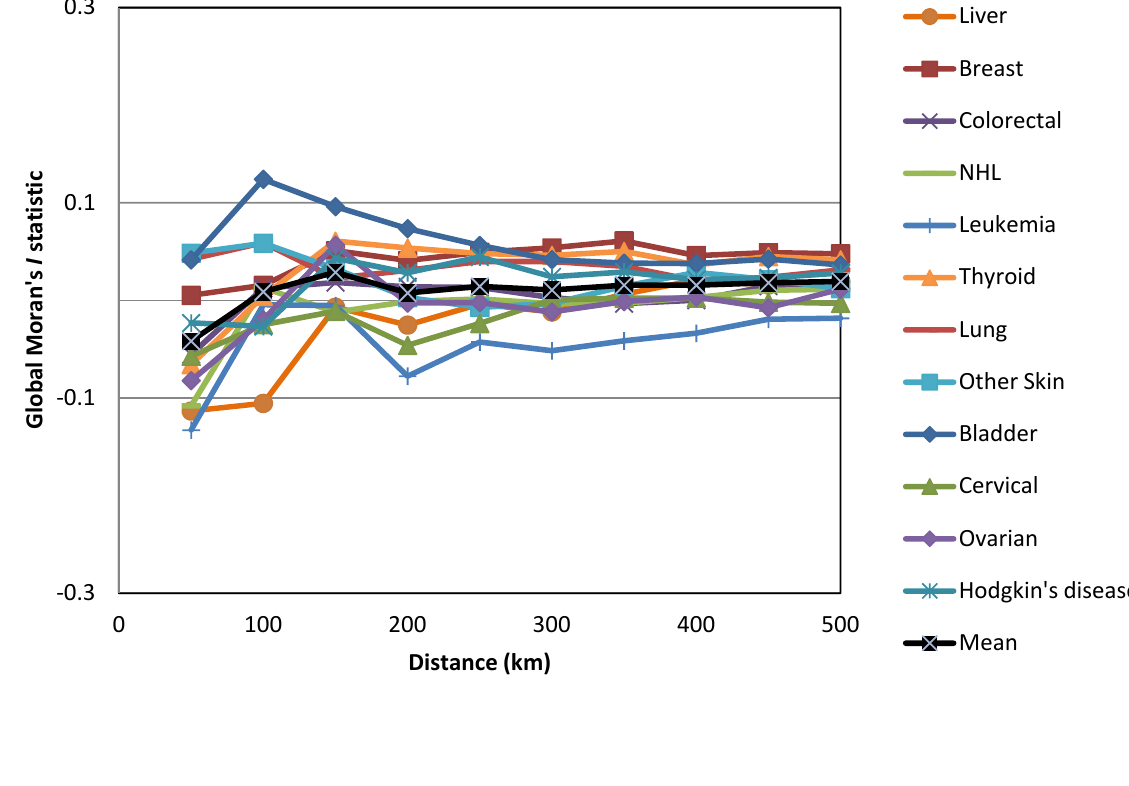
Figure 3. Global Moran’s I statistics for the most common cancers in